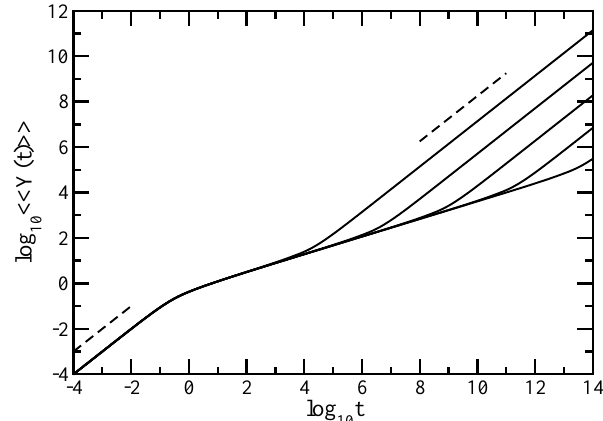
Figure 4. The averaged monomer displacement under the action of an external force in the Rouse model. Displayed in dimensionless units is the << Y ( t ) >> for the fractal cactus networks with N = 3 6 , 3 9 , 3 12 , 3 15 , and 3 18 from above. For guidance, the black dashed lines indicate that the slope equals 1.